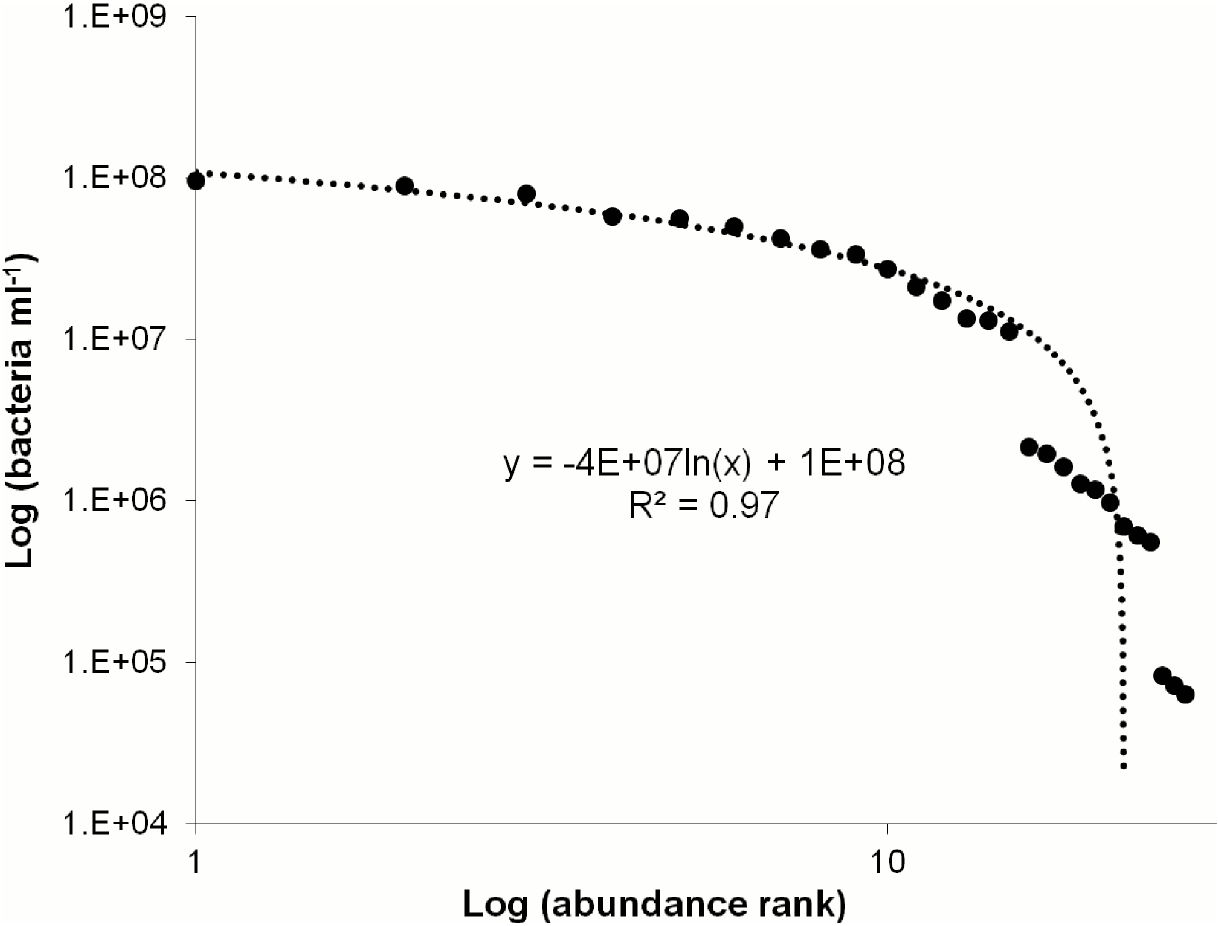
Fig 3. Average bacterial rank abundance using all treatment triplicates. Data points follow a logarithmic trend achieved by steps of power laws for each observed group. High medium and low bacterial concentration groups fit the power law equations y = 2E+08x -0.84 (R 2 = 0.84), y = 5E+10x -3.57 (R 2 = 0.98) and y = 6E+09x -3.49 (R 2 = 1) respectively.